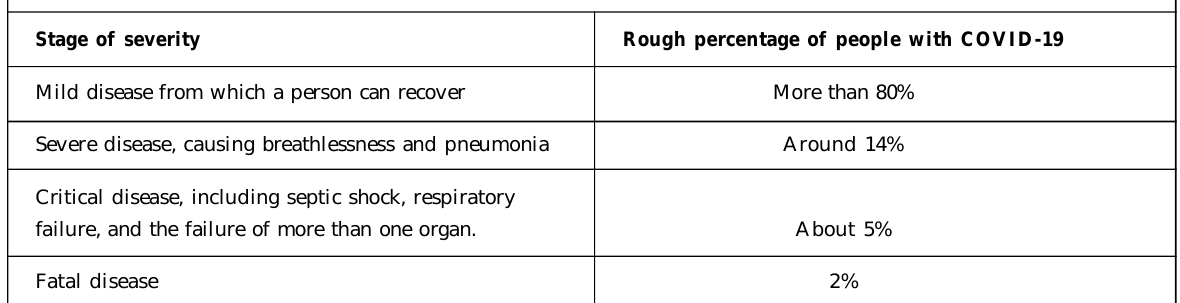
Figure 2: Corona virus entry